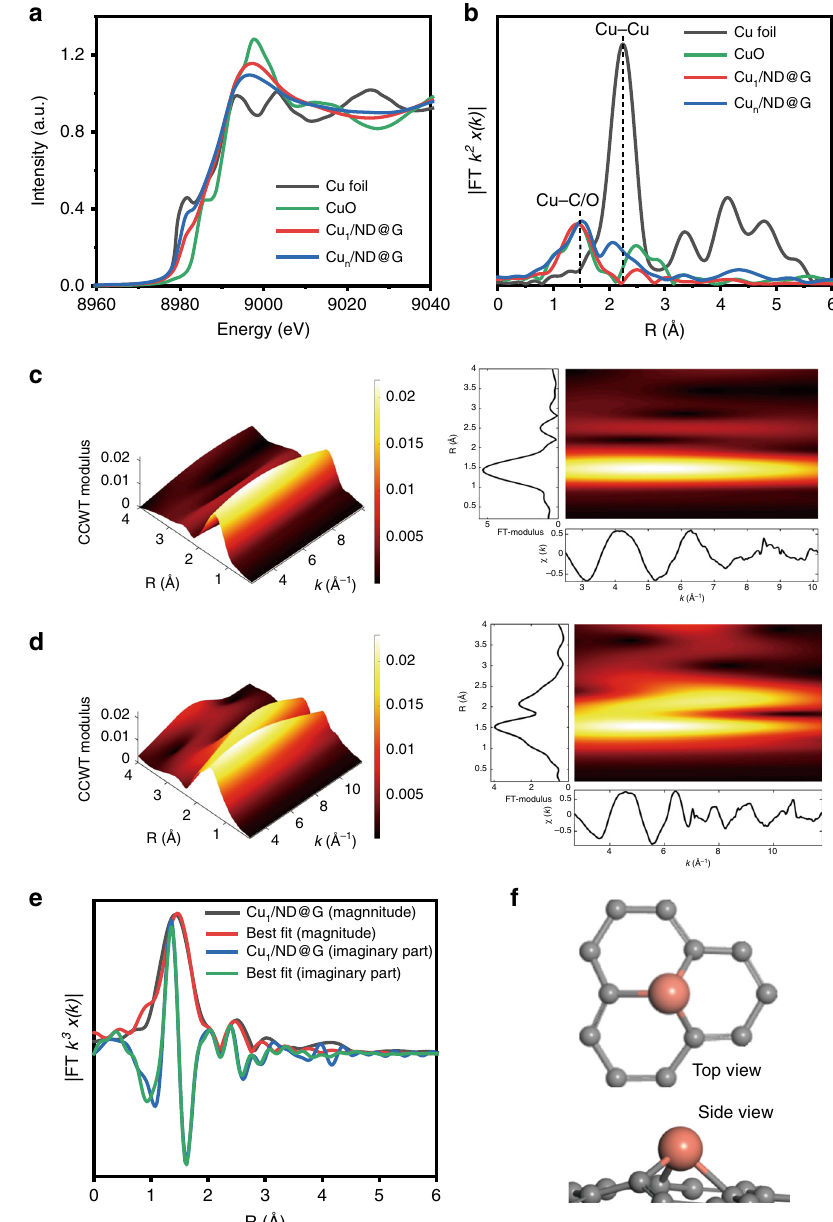
Fig. 2 Synchrotron XAFS measurements of Cu 1 /ND@G and Cu n /ND@G catalysts. a Cu k -edge XANES pro fi les for Cu 1 /ND@G, Cu n /ND@G, Cu foil, and CuO. b Cu k -edge EXAFS spectra in R space for Cu 1 /ND@G, Cu n /ND@G, Cu foil, and CuO. c WT analysis of Cu 1 /ND@G. d WT analysis of Cu n /ND@G. e EXAFS fi tting curve for Cu 1 /ND@G. f The optimized Cu-C 3 structure; color code: Cu (orange), C